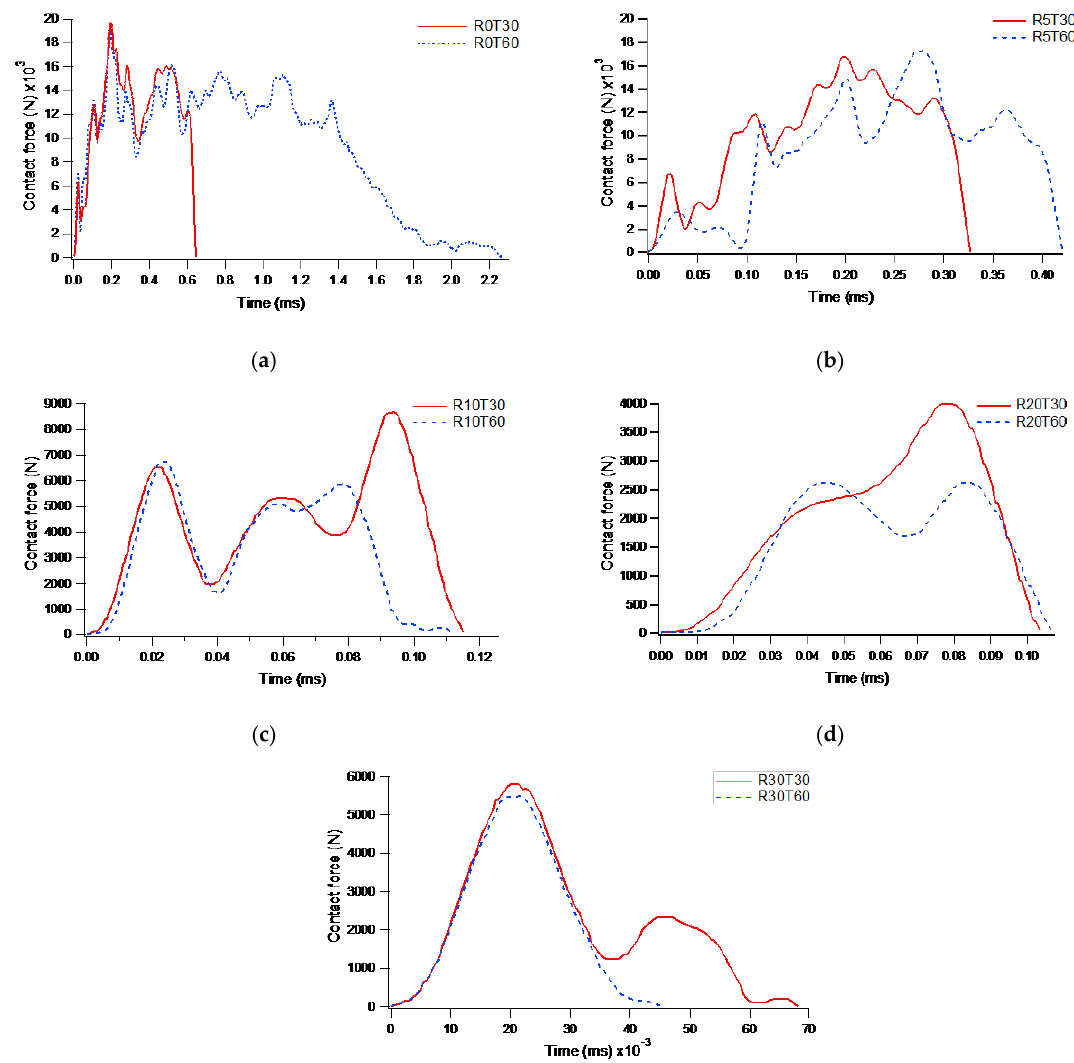
Figure 12. Variation of contact force versus time (F−t) curves for: ( a ) un-reinforced iron specimen sintered for 30 min and 60 min (R0T30, R0T60); ( b ) Fe + 5 vol.% B 4 C sintered for 30 min and 60 min (R5T30, R5T60); ( c ) Fe + 10 vol.% B 4 C sintered for 30 min and 60 min (R10T30, R10T60); ( d ) Fe + 20 vol.% B 4 C sintered for 30 min and 60 min (R20T30, R20T60); ( e ) Fe + 30 vol.% B 4 C sintered for 30 min and 60 min (R30T30, R30T60).